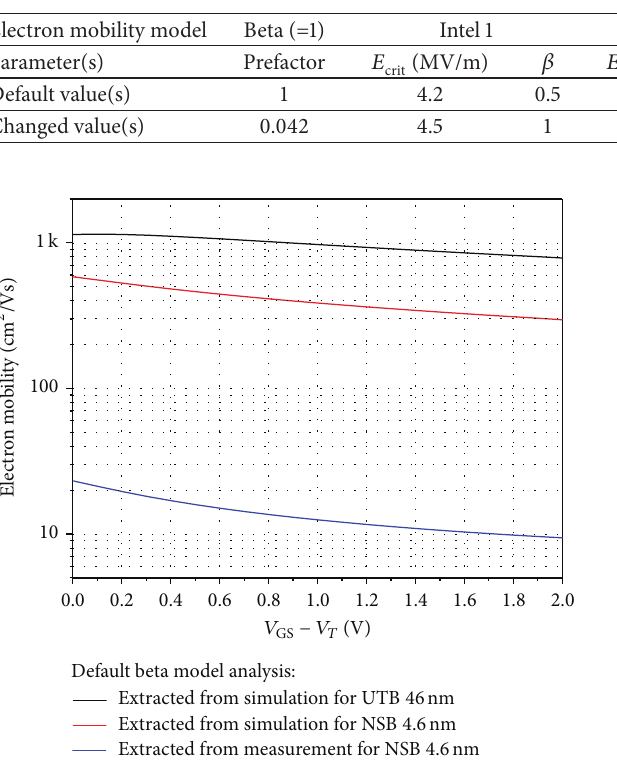
Figure4:Theeffectiveelectronmobilityversus 𝑉 GS −𝑉 𝑇 relationship (semilog)extractedfromthesimulatedtransfercharacteristicsusing the default beta model for UTB and NSB devices. For comparison the electron mobility extracted from the measurement for NSB device. 𝑉 DS is fixed to 0.1V.